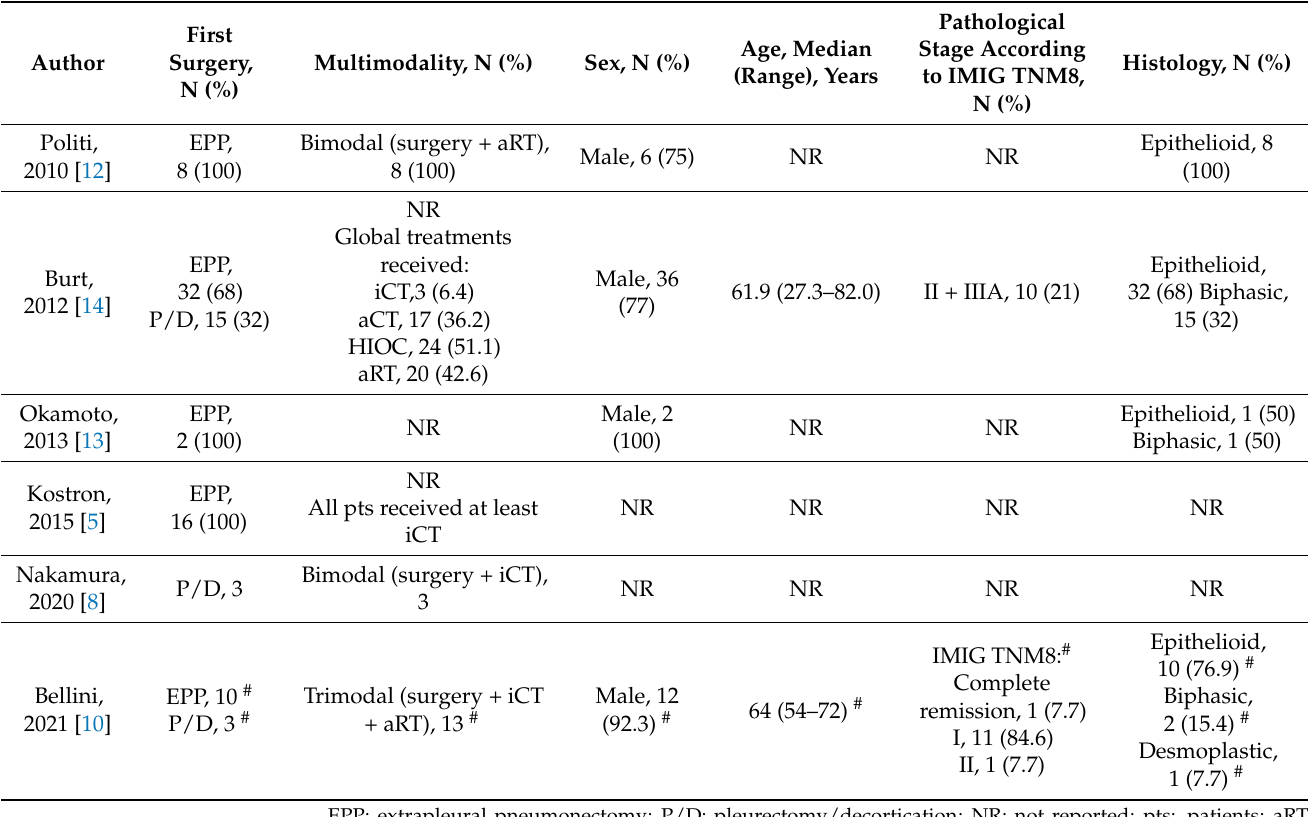
Table 3. The basic characteristics of MPM patients who underwent second